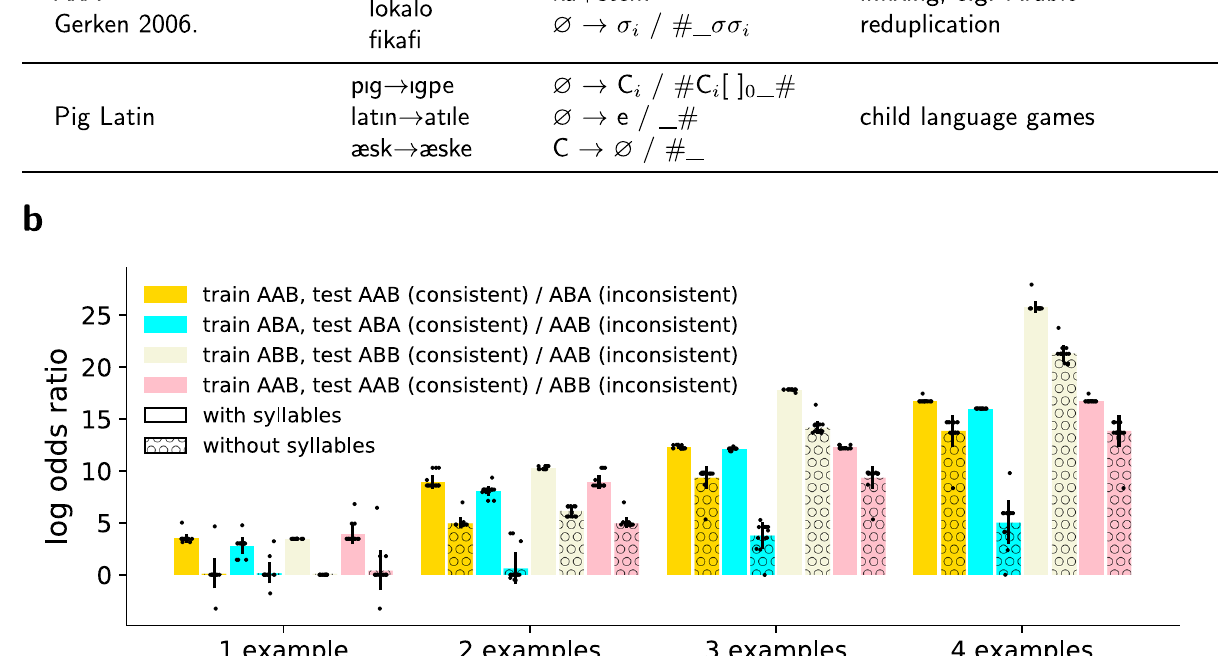
Fig.6|Modelingarti fi cialgrammarlearning.a Childrencanfew-shotlearnmany qualitatively different grammars, as studied in controlled conditions in AGL experiments. Our model learns these as well. Grammar names ABB/ABA/AAx/AxA refertosyllablestructure:A/Barevariablesyllables,andxisaconstantsyllable.For example,ABBwordshavethreesyllables,withthelasttwosyllablesbeingidentical. NB: Actual reduplication is subtler than syllable-copying 20 . b Model learns to dis- criminate between different arti fi cial grammars by training on examples of gram- mar (e.g., AAB) and then testing on either unseen examples of words drawn from the same grammar (consistent condition, e.g., new words following the AAB pat- tern); or testing on unseen examples of words from a different grammar (incon- sistent condition, e.g. new words following the ABA pattern), following